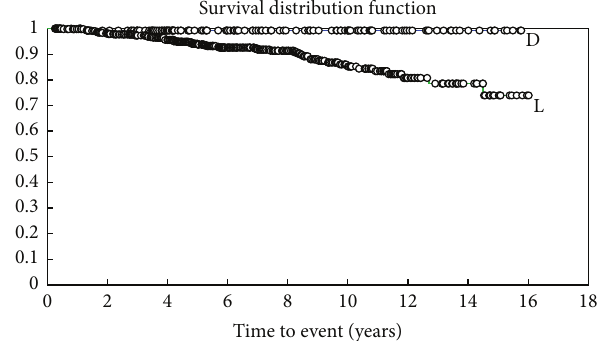
Figure 2: Kaplan Meier survival curve shows two groups—patients with Fitzpatrick skin types I–III (light-skinned—L) with worse times to first malignant tumour and patients with Fitzpatrick types IV–VI (dark skinned—D) where only one malignant tumour occurred.